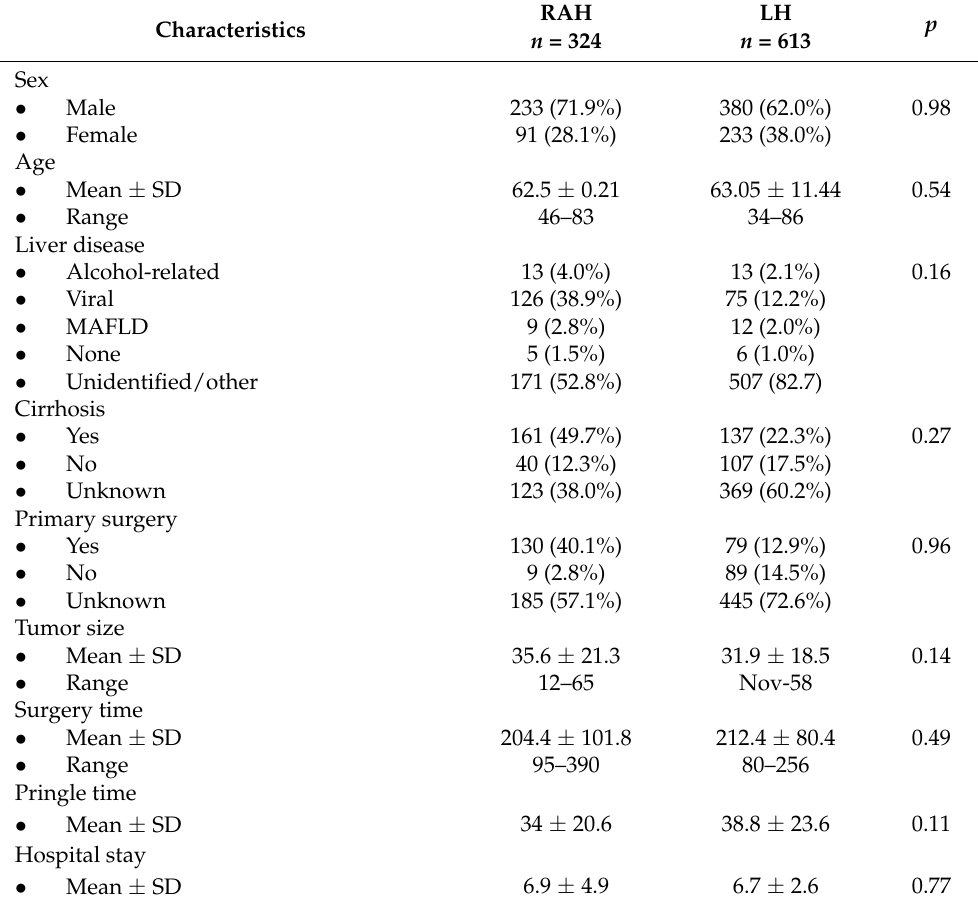
Table 3. Aggregated